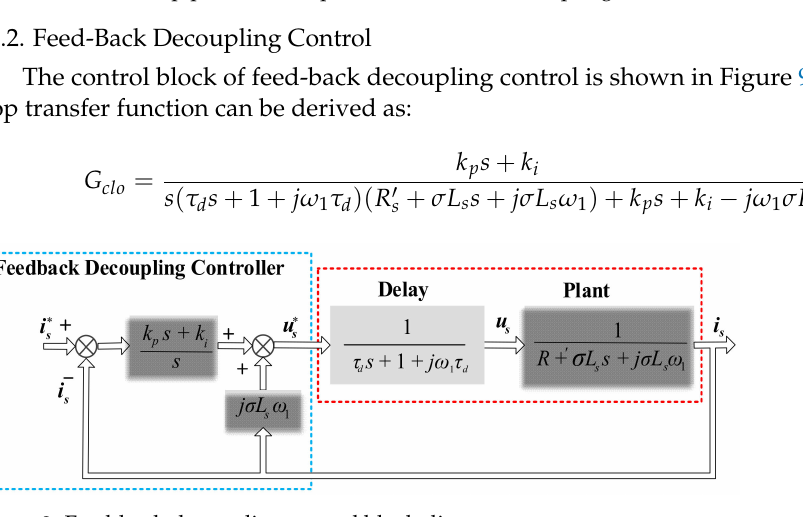
Figure 8. Closed-loop pole-zero map of feed-forward decoupling control.